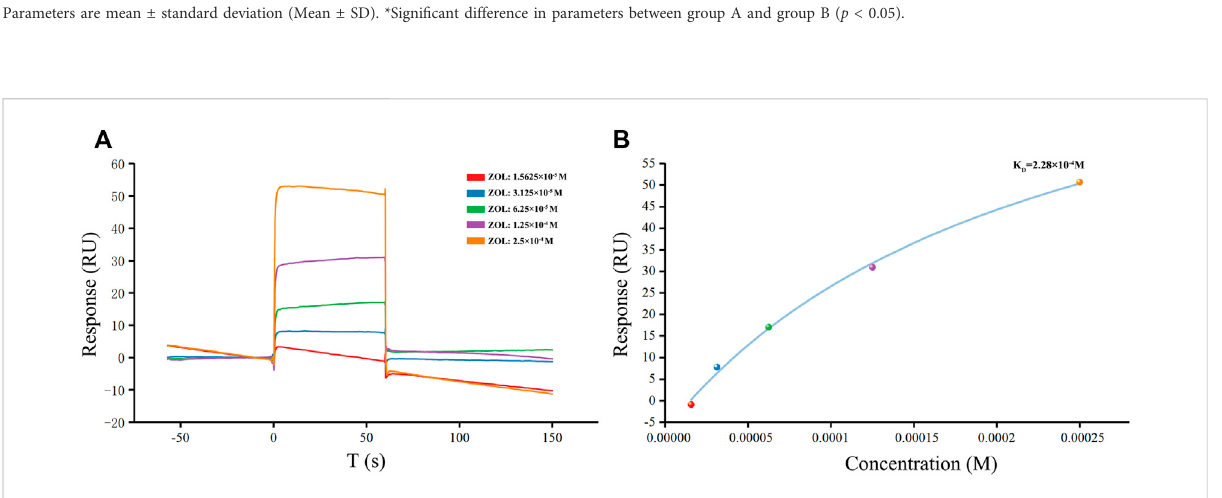
FIGURE 3 SPR detection of human RANKL and ZOL. (A) Plot of CM5 sensor chip containing immobilized RANKL with fl ows of different concentrations of ZOL. The response unit values were proportional to the ZOL concentration within the selected ranges (B) Calibration curve of the steady-state binding response against the ZOL